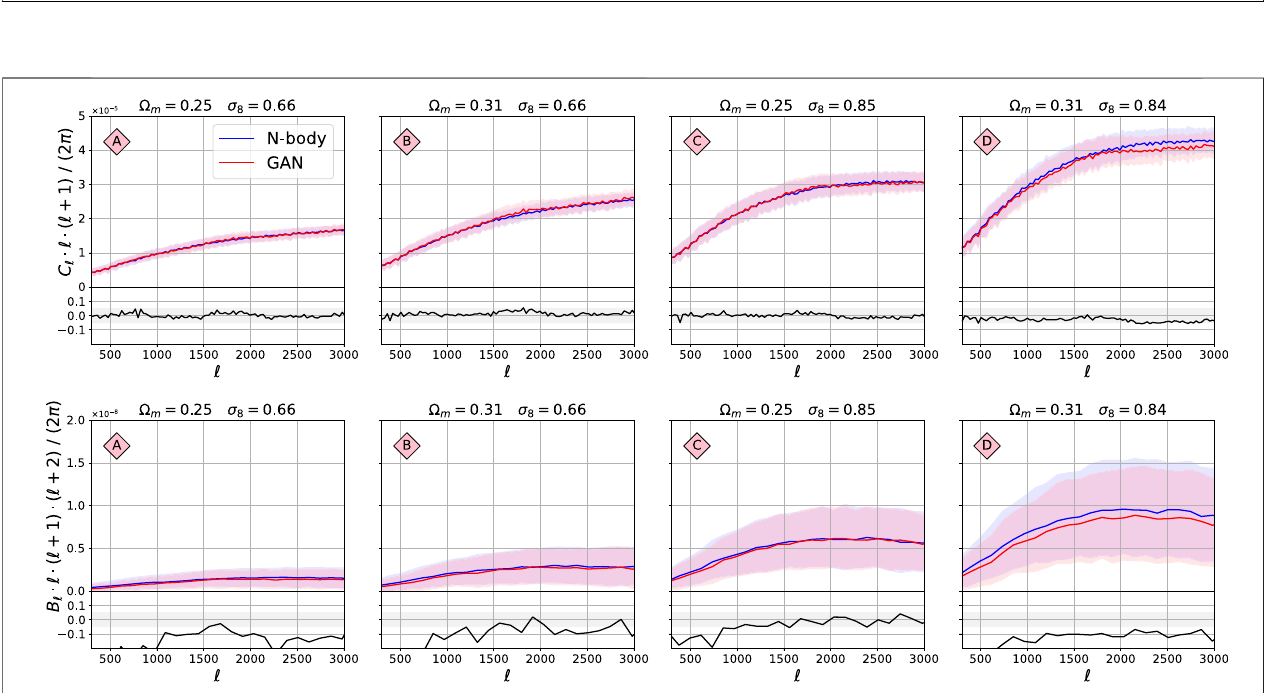
FIGURE6| Comparisonofthe2-ptand3-ptfunctionsbetweentheoriginalN-bodymaps andGAN-generated maps.Thestructure ofthis fi gureisthesameasfor Figure 5 .